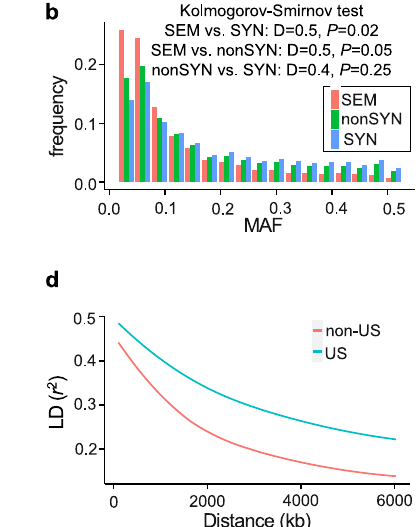
Fig. 2 | The patterns of genetic diversity and linkage disequilibrium in the Pgt panel. a Classi fi cation of SNPs based on their effect and location relative to gene models (intergenic, 5kb upstream and downstream of a gene, UTRs, fi rst and last exons, and introns). b MAF (minor allele frequency) of nonsynonymous and synonymousSNPs.Atwo-sidedKolmogorov – Smirnovtestwasappliedtocompare